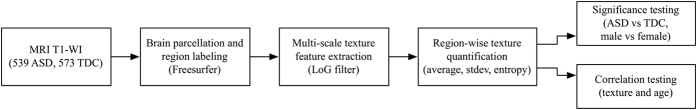
Schematic diagram of the proposed method for identifying significant texture differences related to autism, sex and age, in various brain regions.